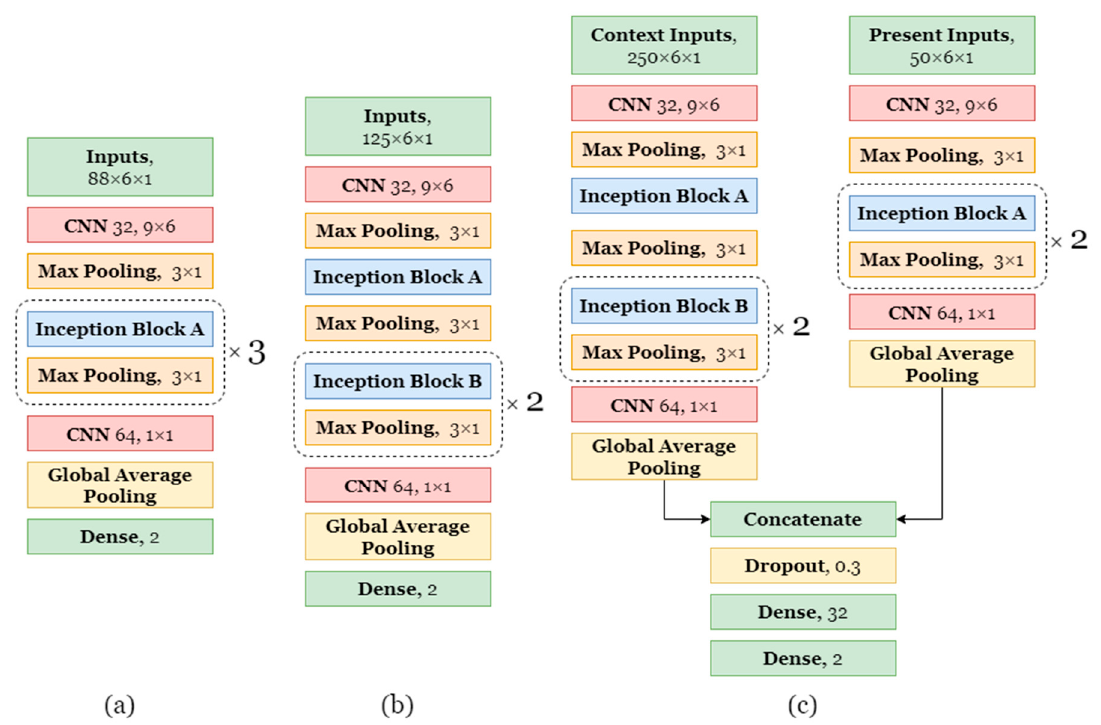
Figure 6. Architectures of the proposed models for bite detection. ( a ) Short architecture. ( b ) Medium architecture. ( c ) Long architecture.